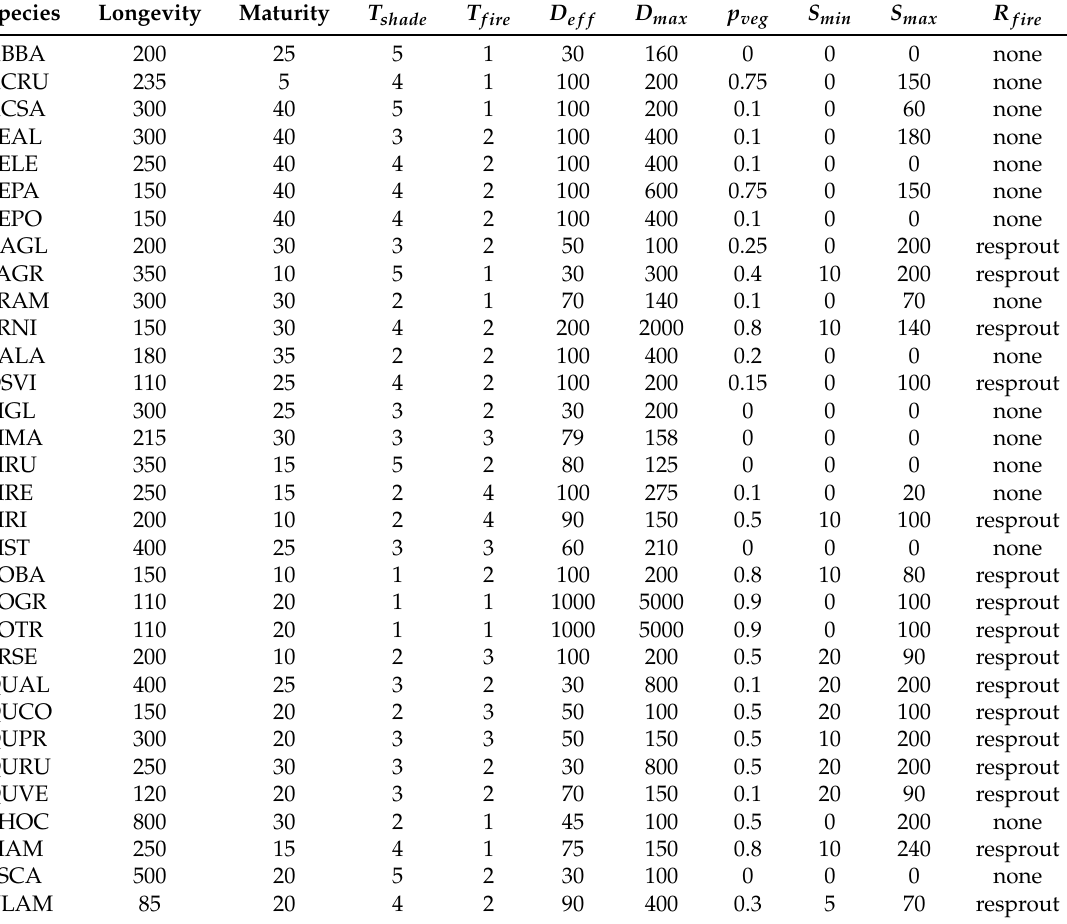
Table A15. Species parameters; only ACRU and QURU were simulated.